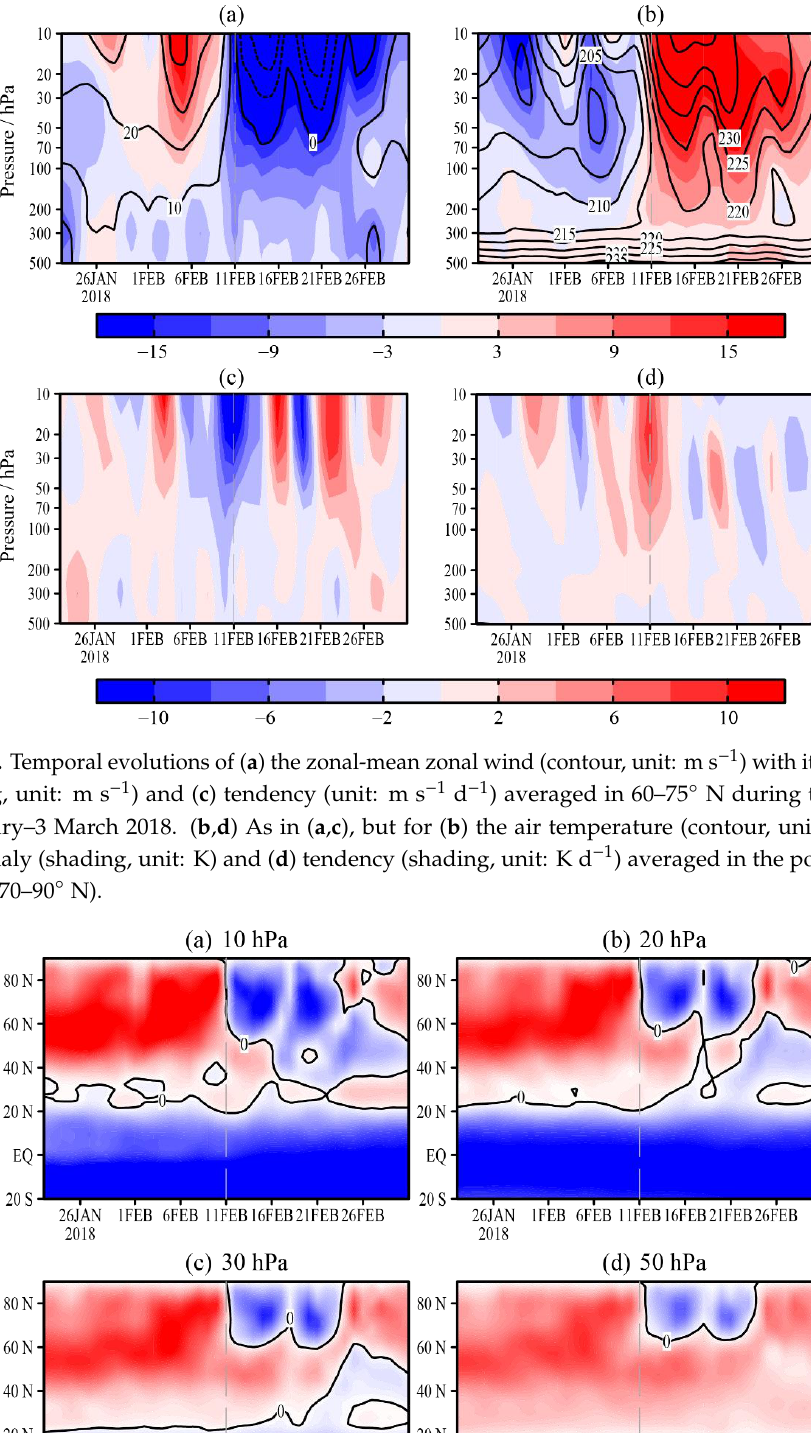
Figure 1. Temporal evolutions of ( a ) the zonal-mean zonal wind averaged in 60° – 75° N and ( b ) meridional gradient of zonal-mean temperature between 60° N and the North Pole at 10 – 50 hPa during the period 22 January – 3 March 2018 (within 40 days before and after the onset date of stratospheric sudden warming (SSW) shown by the vertical dashed line). Figure 2 shows the temporal evolutions of the zonal-mean zonal wind averaged in 60° – 75° N and the air temperature averaged in the polar region (0 – 360°, 70° – 90° N) with their anomalies and tendency. Accompanying the reversal of zonal wind direction, positive (negative) anomalies of the